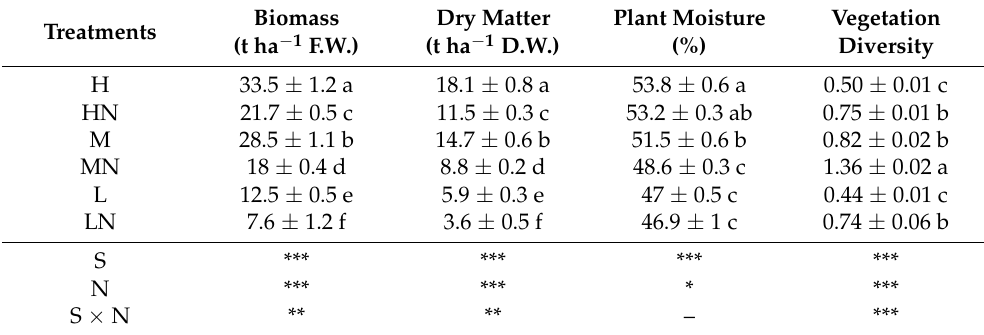
S × N ** ** – *** Mean values ± S.E.s (n = 3) are displayed. Significant differences are denoted by letters ( p <0.05). The two-way ANOVA analysis results are also shown for indicating the significance of main (S, salinity levels; N, N addition) and interaction effects: ***, p < 0.001; **, p < 0.01; *, p < 0.05; –, not